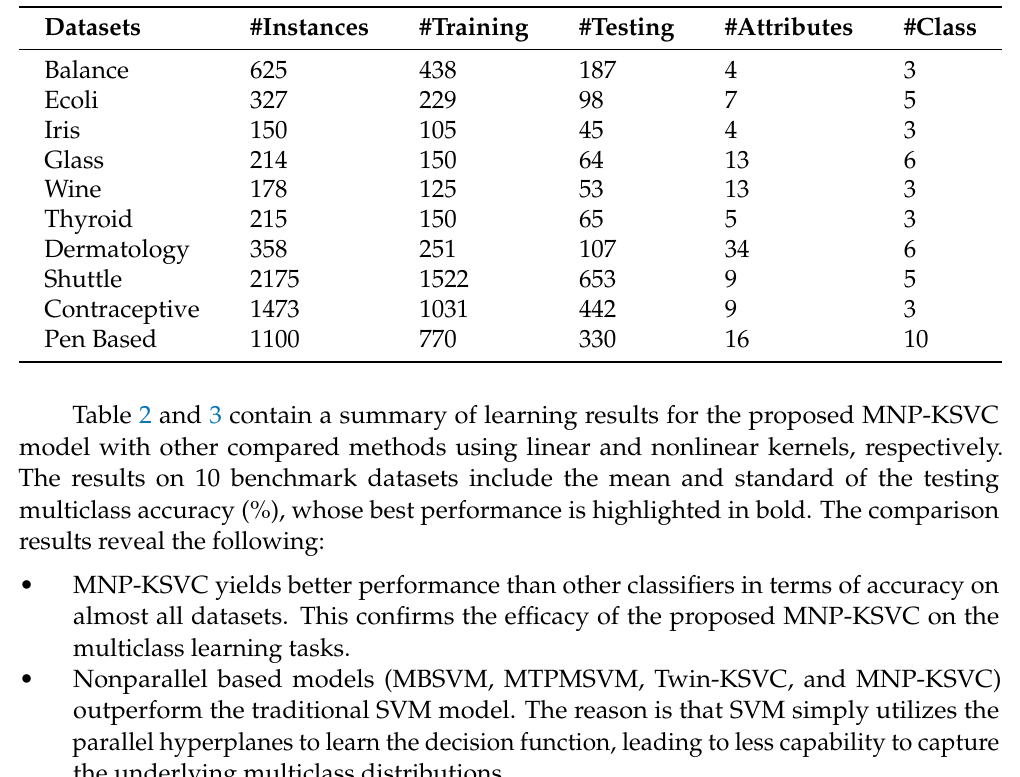
Table 1. Statistics for benchmark datasets used in experiments. # denotes the corresponding